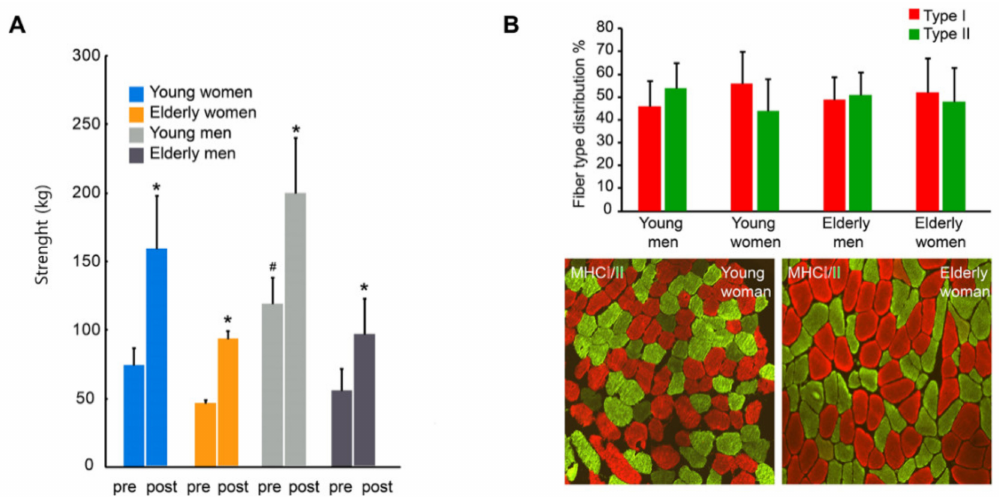
Figure 2. Muscle strength and muscle fiber type composition. ( A ) Quadriceps muscle strength measured in a three repetition maximum test before and after six weeks of resistance exercise training in elderly and young men and women. ( B ) Pre-intervention muscle fiber type distribution shown as bar graph and by representative cross-sectional images of m. vastus lateralis in a younger and older woman showing fiber type distribution of myosin heavy chain (MHC) type I (red) and type II (green). * p < 0.05, post-exercise vs. pre-exercise within the same group. # p < 0.05, pre-exercise, young men vs. young women. n = 5 elderly men, n = 4 elderly women, n = 5 young men, and n = 4 young women. All data are presented as means ± SD. Table 2. Mitochondrial markers. Young Group Elderly Group Post Pre Training